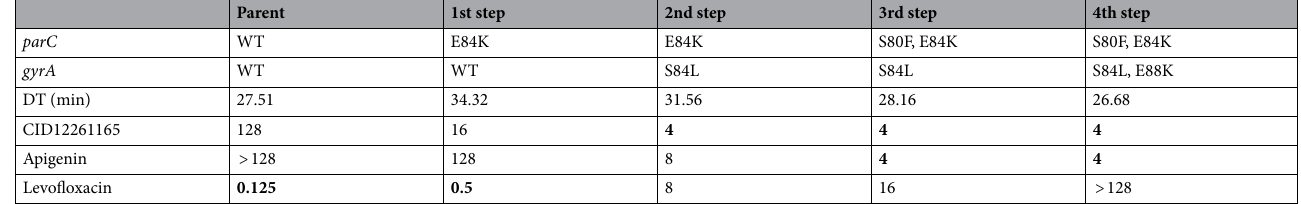
Table 2. MIC values of S. aureus Quinolone stepwise mutant strain MR5867. DT doubling time, WT wild type. MICs ≤ 4 mg/L are in